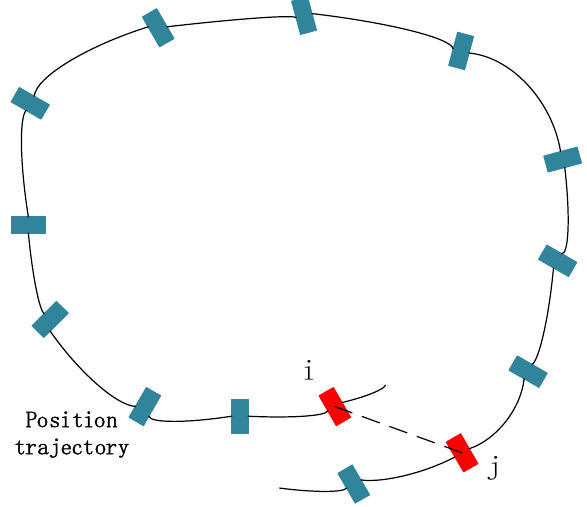
Figure 6. Closed ‐ loop detection. Figure 6. Closed-loop